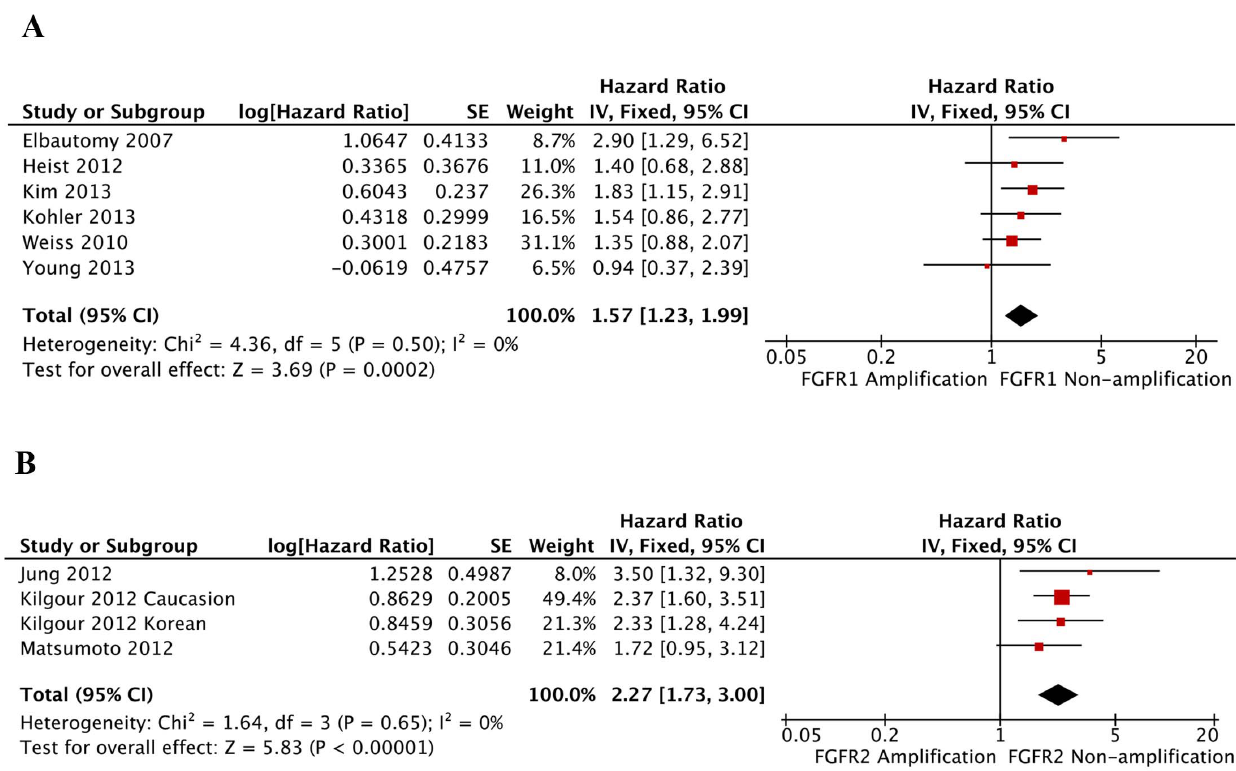
Figure 3. Forest plots of studies evaluating HR of overall survival, comparing high FGFR amplification and non-amplification. (A) Analysis of FGFR1 amplification and overall survival in various cancers. (B) Analysis of FGFR2 amplification and overall survival in gastric cancer. The horizontal lines represent 95% CIs for estimating HR of FGFR gene amplification versus non-amplification. ( & ) Overall estimates of the effects. CI, confidence interval; HR, hazard ratio; IV, XXX; SE, standard error.